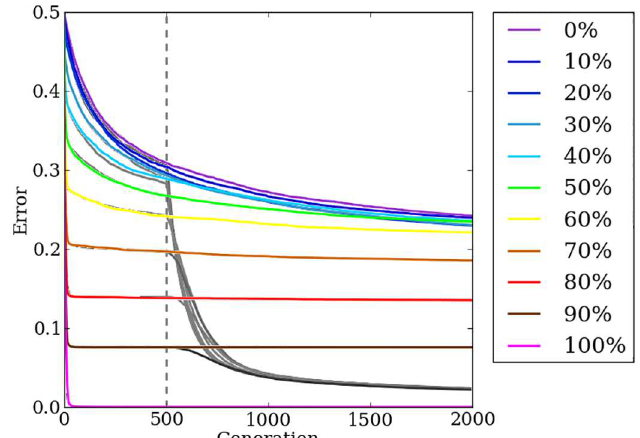
Fig 5. The mean error of HyperNEATand Preset-Switch-HybrID generation champions over 2,000 generations on the target weights experiment. The line colors indicatethe regularityof the problem tested. Preset-Switch-HybrID treatments diverge from HyperNEAT treatments at 500 generationsand are